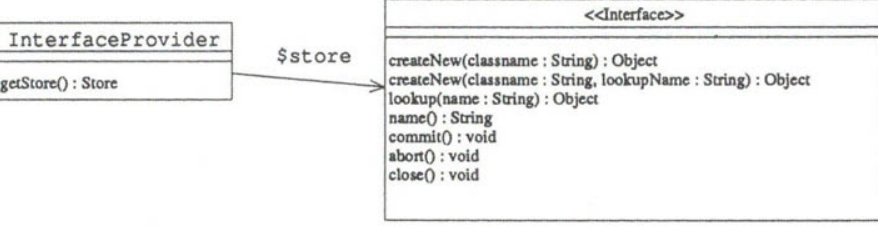
Fig. 4. The InterfaceProvider and Store